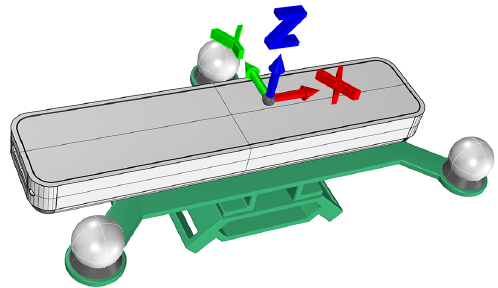
Figure 1. 3D Model of jig with attached Intel T265